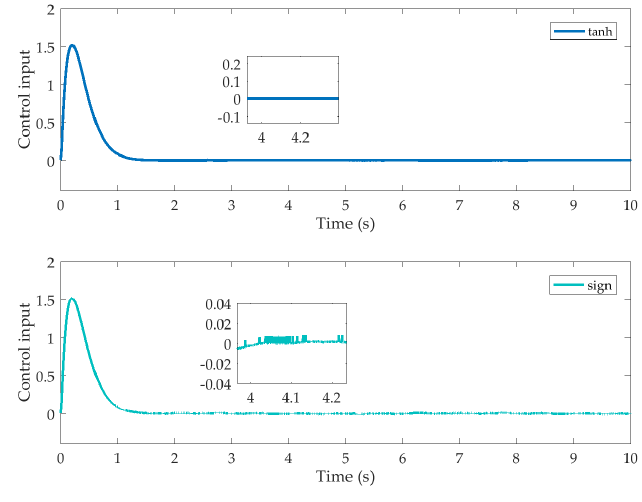
Figure 9. Time response of control input.